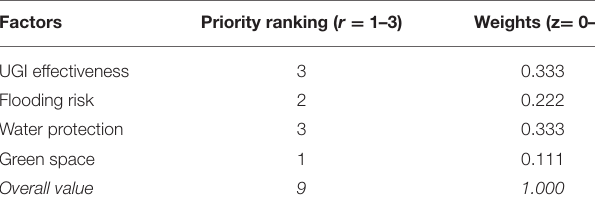
TABLE 2 | Priority ranking and weight of LSA